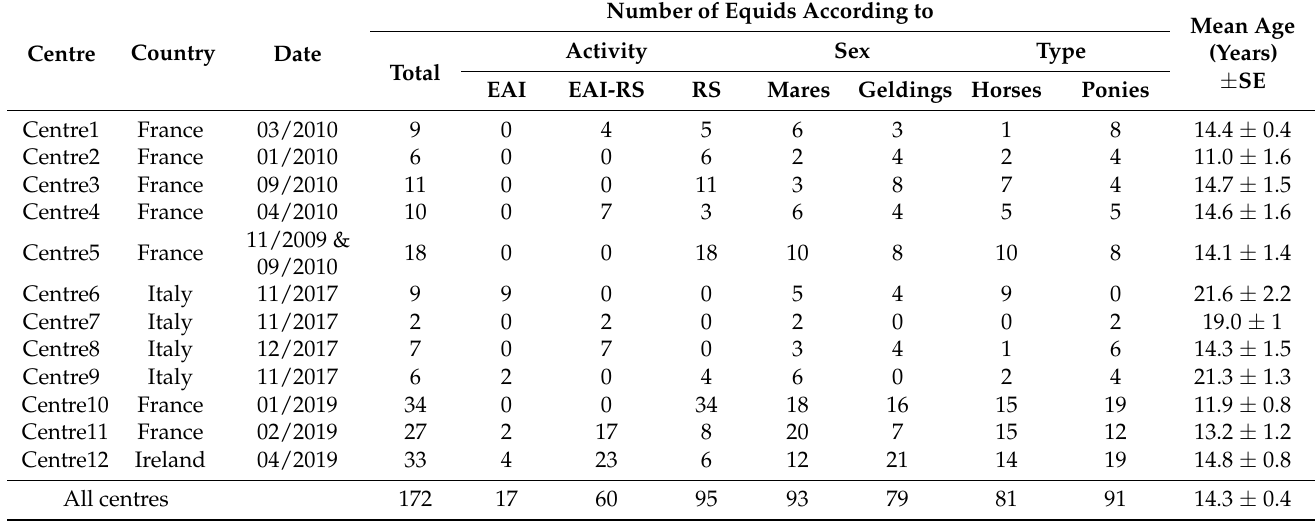
Table 1. Subjects’